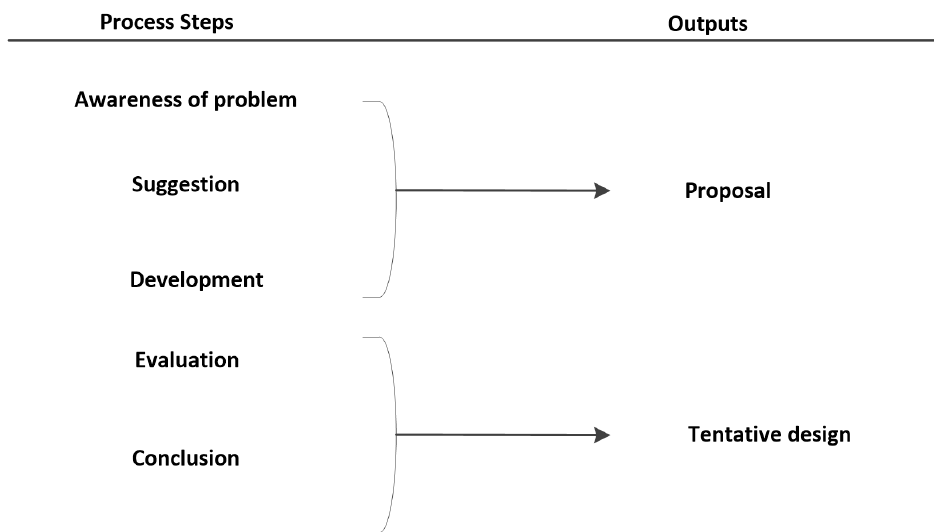
Figure 3. Design research